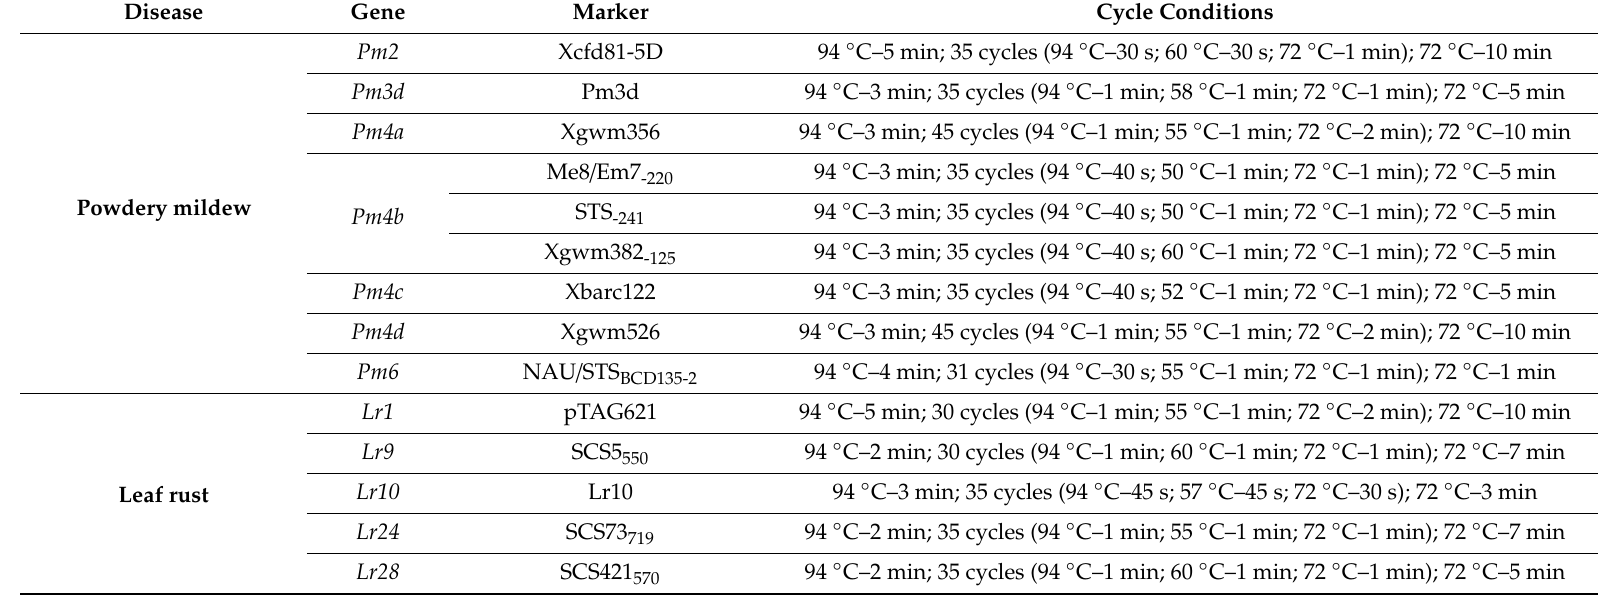
Table 3. Amplification conditions for primer sets for identifying DNA markers linked to powdery mildew and leaf rust resistance